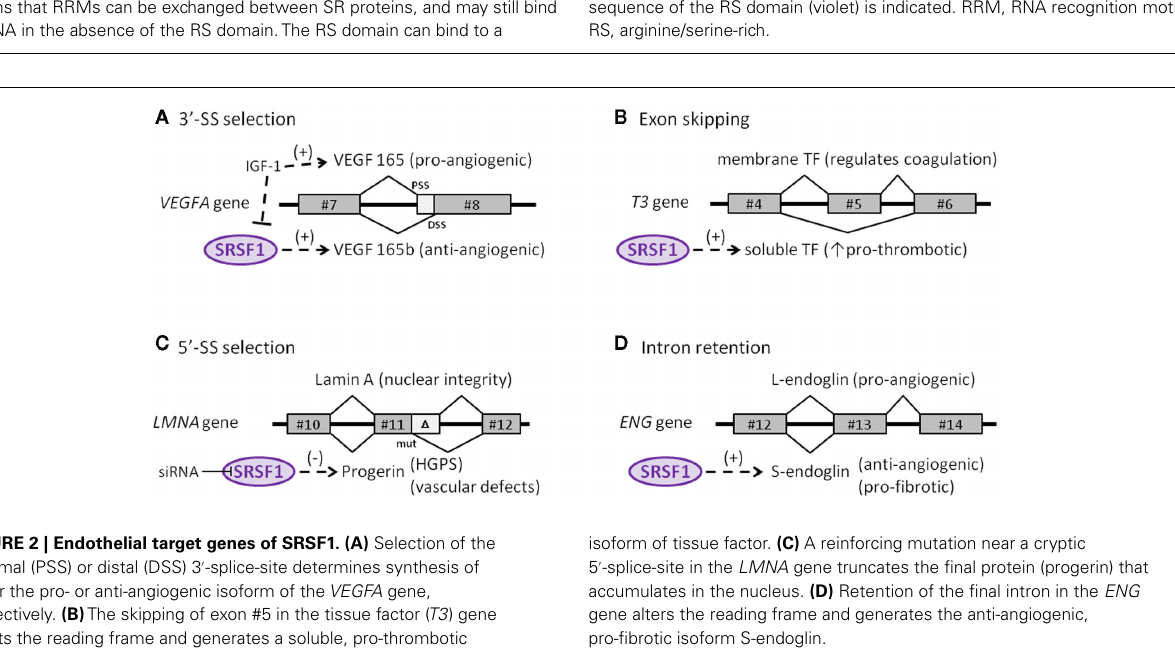
FIGURE 2 | Endothelial target genes of SRSF1. (A) Selection of the proximal (PSS) or distal (DSS) 3 (cid:2) -splice-site determines synthesis of either the pro- or anti-angiogenic isoform of the VEGFA gene, respectively. (B) The skipping of exon #5 in the tissue factor ( T3 ) gene affects the reading frame and generates a soluble, pro-thrombotic